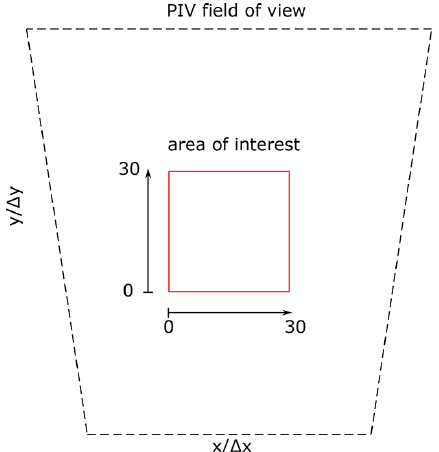
Figure 4. Field of view of PIV measurements and area of interest of the current study. Axes are normalized by the grid